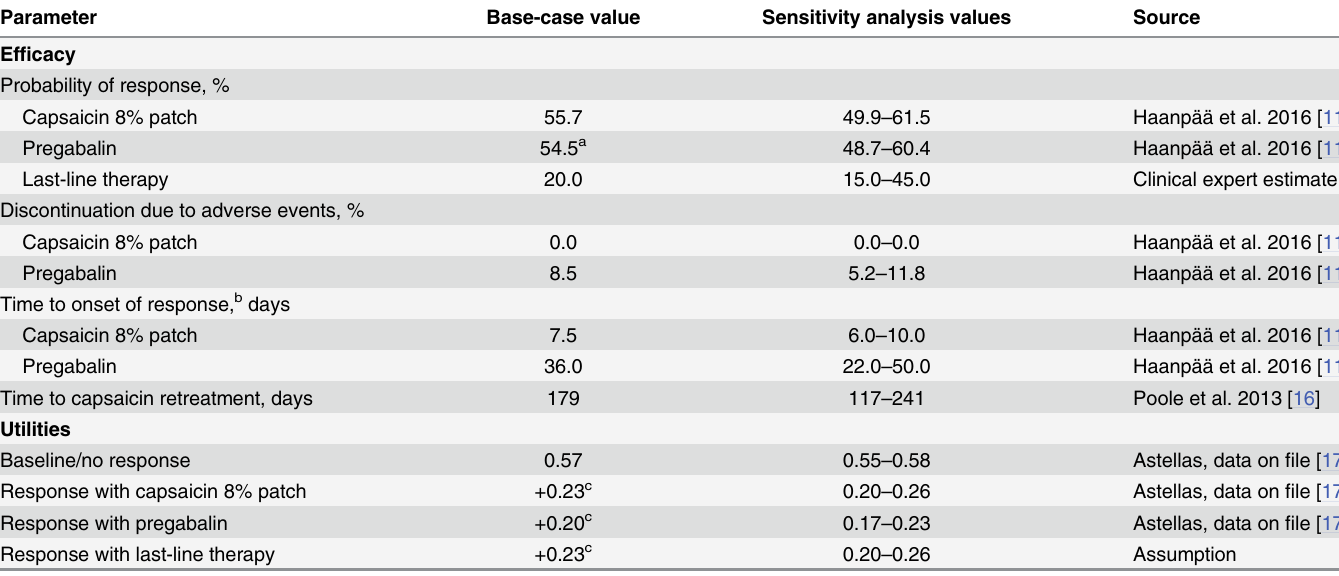
Table 1. Model inputs: efficacy and